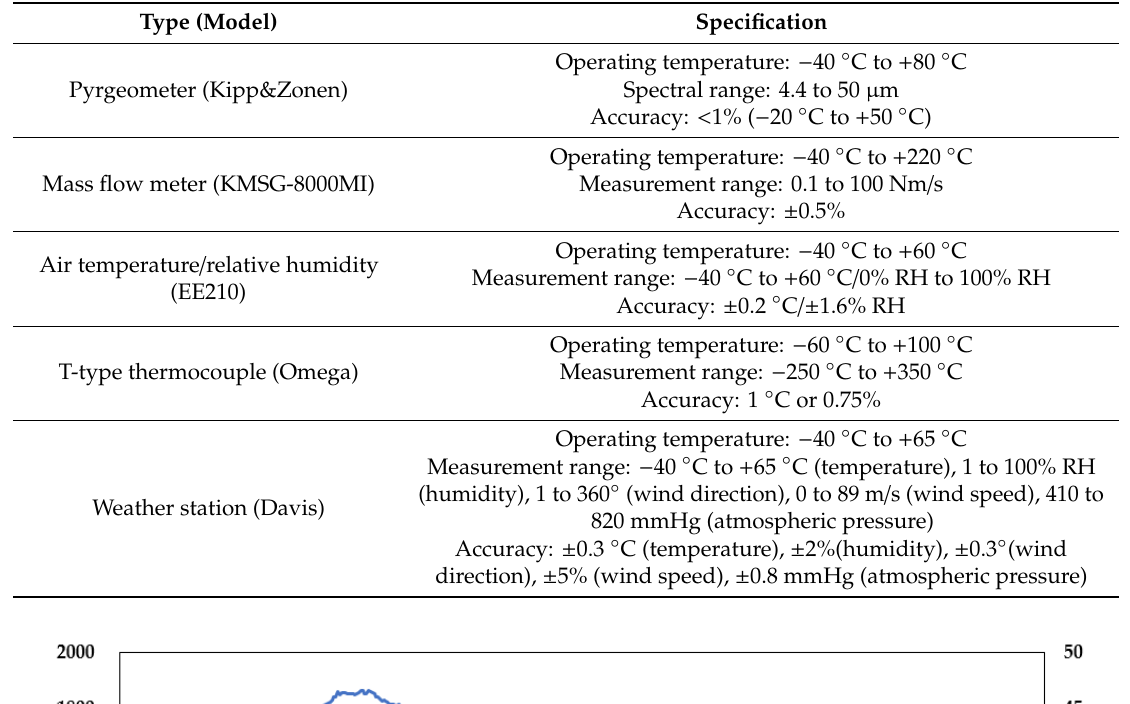
Table 4. Specifications of the measuring equipment.